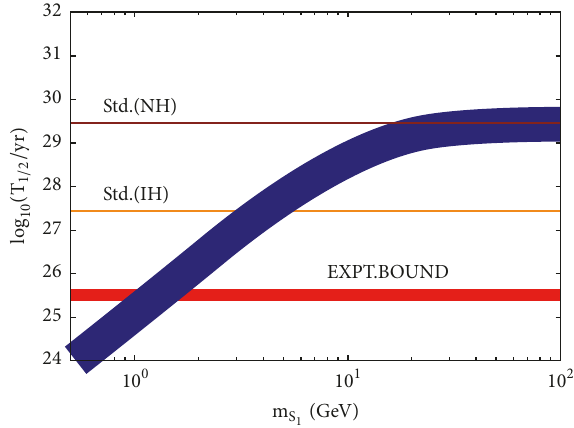
Figure 8: Prediction of double beta decay half-life as a function of sterile neutrino mass 𝑚 푠 GeV (blue shaded curve) where the NH 1 type light neutrino and the sterile neutrino exchange contributions ,𝑚 ) ≫ 𝑚 have been included. Effects of much larger masses (𝑚 푆 푆 3 푆 1 2 have been neglected. The spread in the curve reflects uncertainty in the virtuality momentum 𝑝 = 120 − 190 MeV. For comparison, the standard prediction with NH and IH pattern of light neutrino mass hierarchies is shown by the two respective horizontal lines. The Figure 6: Variation of effective mass parameter as a function of bottommostthickredhorizontallineclosesttotheX-axisrepresents = 2 GeV. For comparison, lightest active neutrino mass 𝑚 1 for 𝑚 푠 1 overlapping experimental bounds from different groups [78–82]. predictions in the standard model supplemented by light neutrino masses of NH type are shown by green dot-dashed curve. For IH pattern of mass hierarchy the standard prediction is shown by red dot-dashed curve.